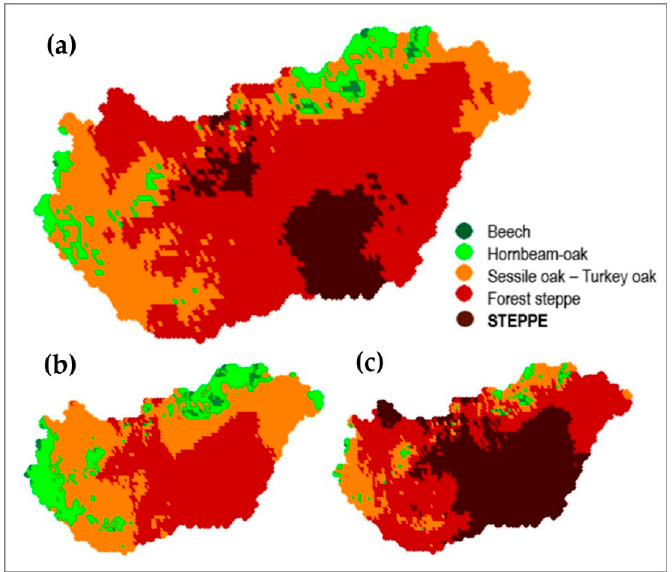
Figure 3. Projected area of macroclimate classes in Hungary for 2021–2050 based on Forestry Aridity Index (FAI) limits. Notice the appearance of grass steppe climate at FAI > 8.50. ( a ) Ensemble mean of the projections. ( b , c ) 66% range of the simulation results (emission scenario: A1B, source: B. Gálos, original; compare to Figure 2).